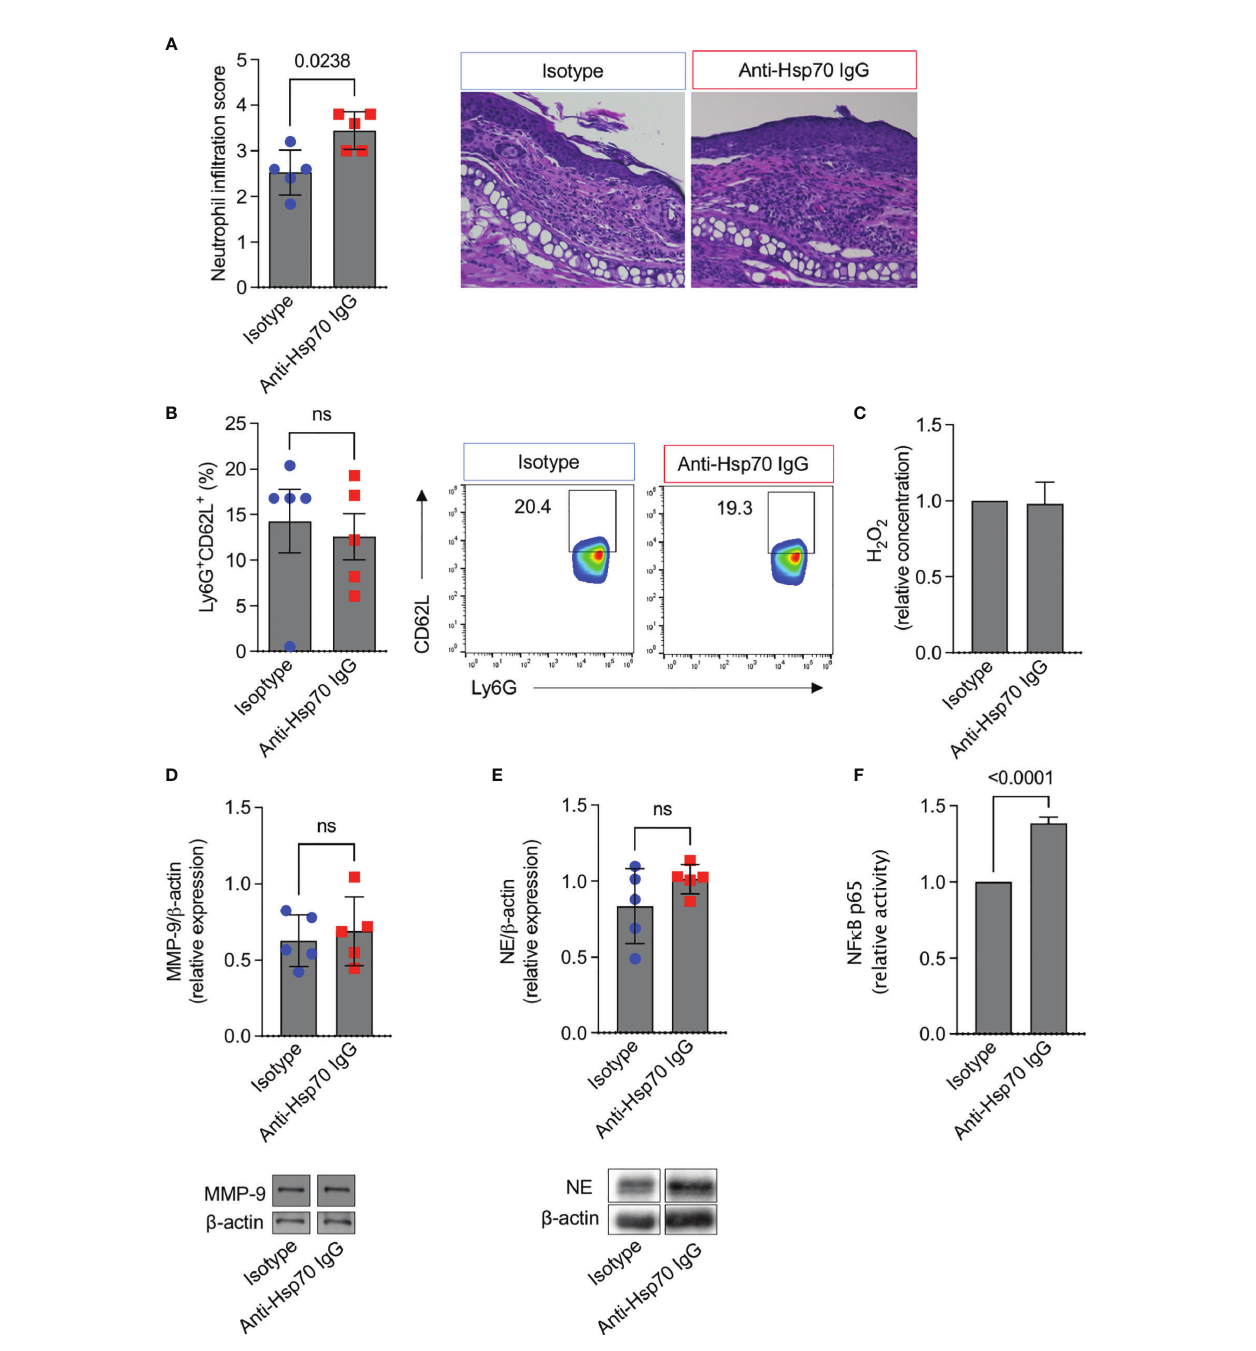
FIGURE 3 | Anti-Hsp70 IgG antibody treatment leads to enhanced dermal neutrophil in fi ltration and NF- k B activity in mice with EBA. Naïve BALB/c mice were injected intraperitoneally with murine anti-Hsp70 IgG or IgG isotype control one day before the initial anti-COL7 IgG injection. (A) Dermal neutrophil in fi ltration scores of H&E-stained skin sections at the end of the observation period (day 12). Representative histological images are shown on the right. (B) Flow cytometric analysis of peripheral blood neutrophil activity (Ly6G + CD62L + ) at the end of the observation period (day 12). Representative cytometric results are shown on the right. (C) Plasma H 2 O 2 levels at the end of the observation period (day 12). Cutaneous expression of (D) MMP-9 or (E) neutrophil elastase (NE) at day 12. Corresponding representative western blot (below) with MMP-9 or NE expression relative to b -actin levels using densitometry measurements. (F) Relative NF- k B p65 activity was analyzed in nuclear extracts of the skin by ELISA at the end of the observation period (day 12). Data are expressed as mean ( ± SEM) of 5 mice per group. ns, not signi fi